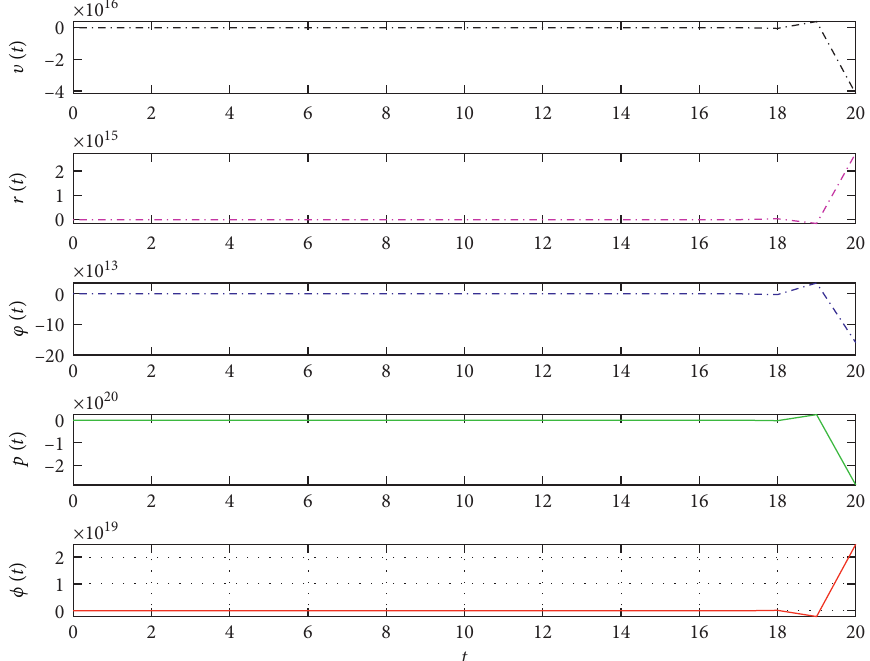
Figure 9: The state response of closed-loop of USVs by using the proposed method in [44].